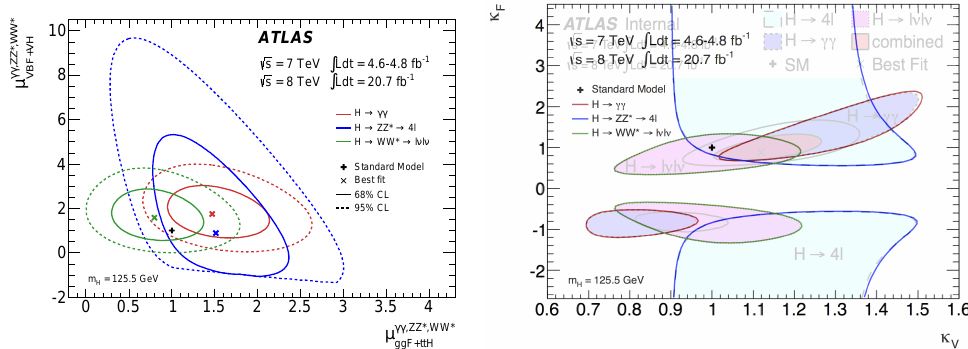
Figure 7: Left: Figure 7 from Ref. [ 43 ] . The corresponding 2-D profile likelihood scans are published on HEPData [ 44–46 ] . Right: An overlay of Figure 10 from Ref. [ 43 ] and the reproduction of the confidence interval contour based on the pub- lished likelihoods. Note the non-Gaussian nature of both sets of contours, and the accuracy of the reproduced results (the colored lines of the reproduced contours overlap with the boundary of the original shaded